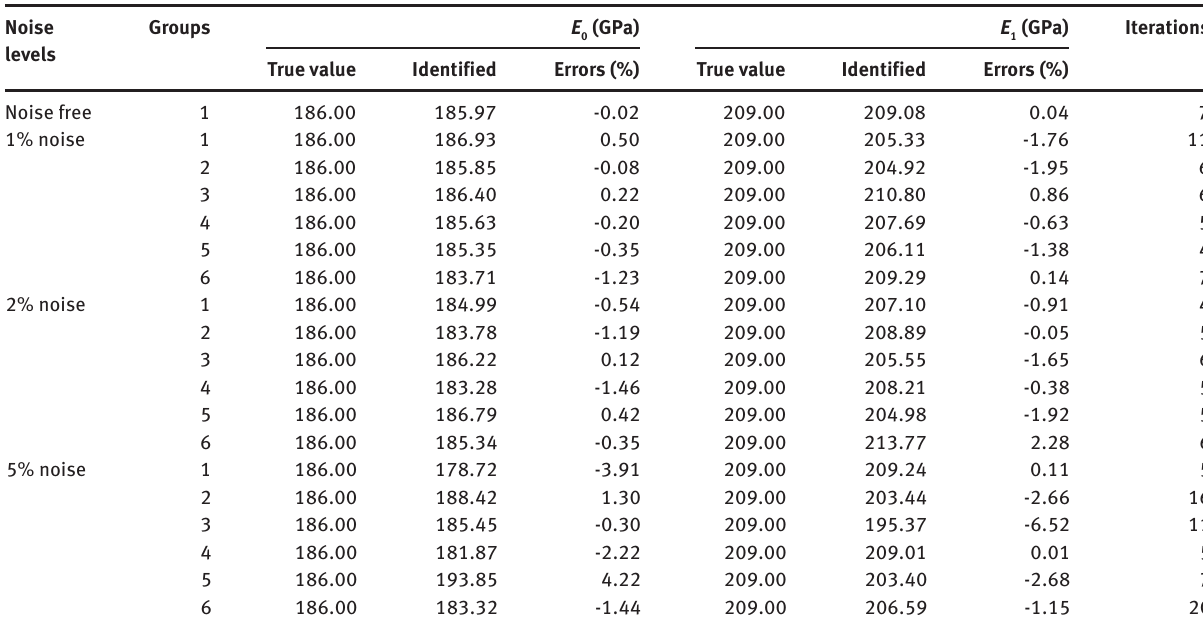
Table 8: Identified parameters of a rectangular FGM plane structure with linear material variation (case 1: initial value E GPa).